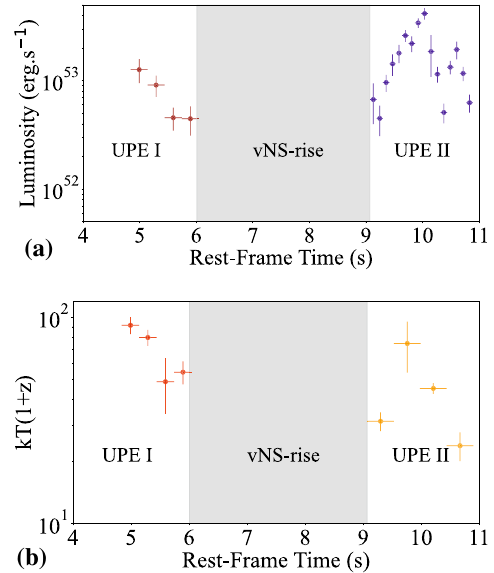
Fig. 5 a The Luminosity during the UPE phase. b The rest-frame tem- perature during the UPE phase. The luminosity and temperature data points are obtained from analyses with Δ t rf = 0 . 3 s time resolution reported in Table 1 (UPE I), and Δ t rf = 0 . 11 s time resolution reported in Table 2 (UPE